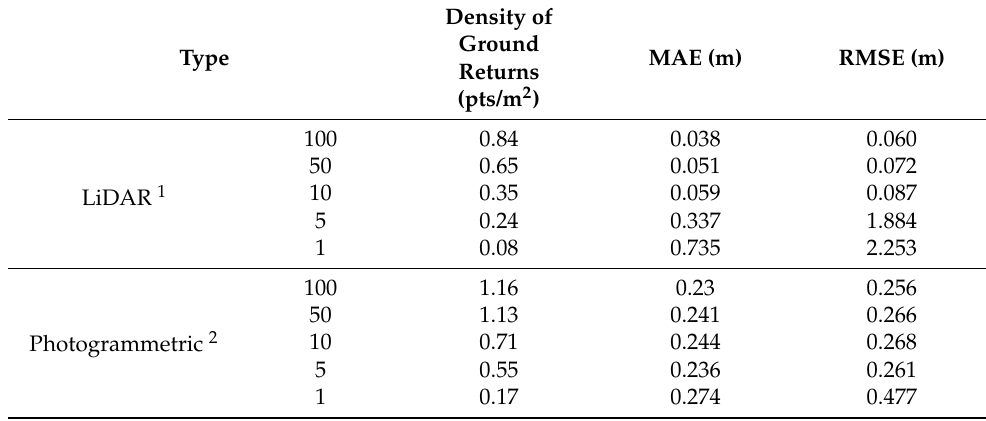
Table 5. Statistics of errors for DTMs of the tea plantation with different point densities.